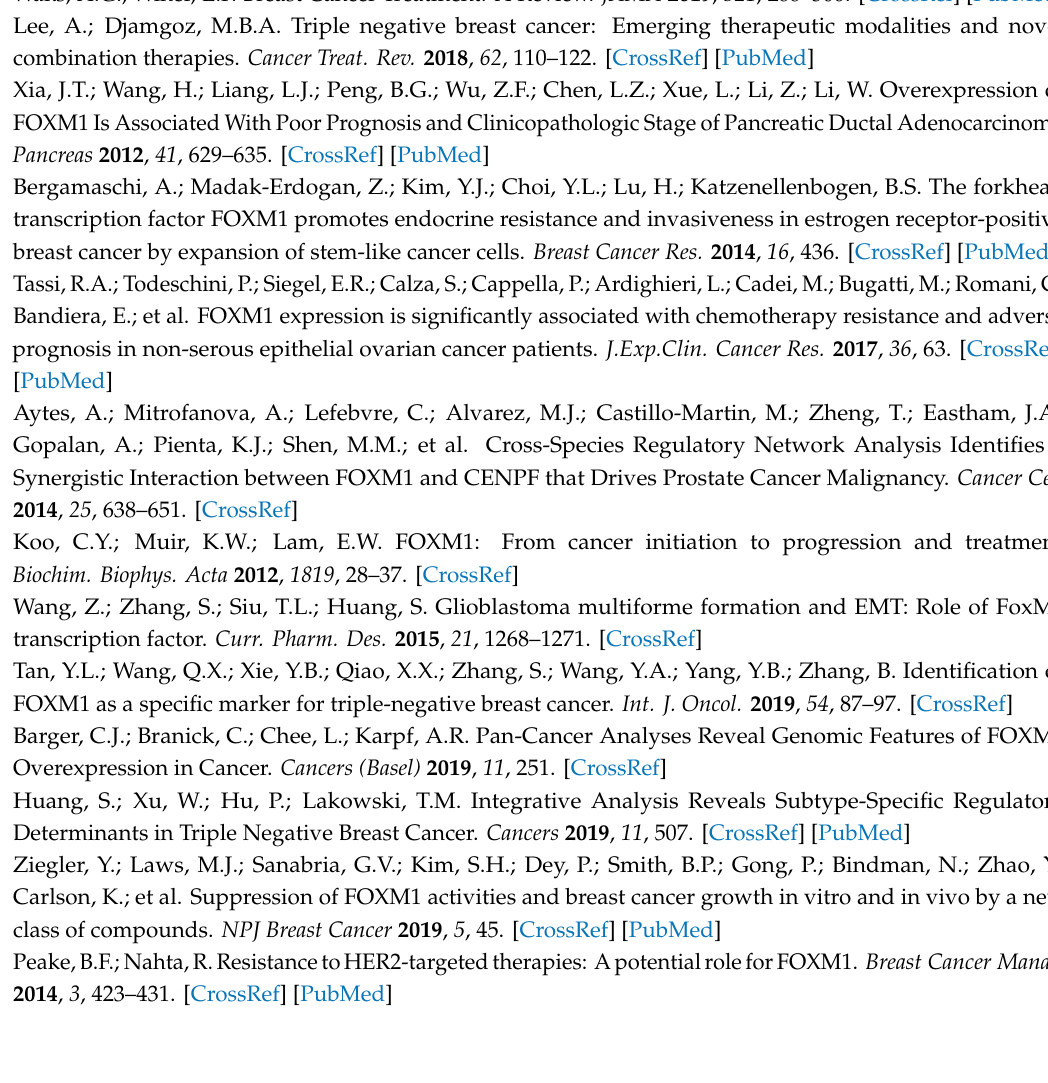
Table S1: Antibodies used in these studies; Figure S1: E ff ect of FOXM1 inhibitors on motility of MDA-MB-231 cells evaluated by Scratch Assay and e ff ects on FOXM1 target gene expression; Figure S2: Body weights of vehicle and compound treated animals during the time course of tumor studies with MDA-MB-231 and DT28 cells; Figure S3: (A) Full Western Blots for the proteins shown in Figure 4A (left), (B) Full Western Blots for the proteins shown in Figure 4A (right); Figure S4: (A) Full Western Blots for the proteins shown in Figure 4B (left), (B) Full Western Blots for the proteins shown in Figure 4B